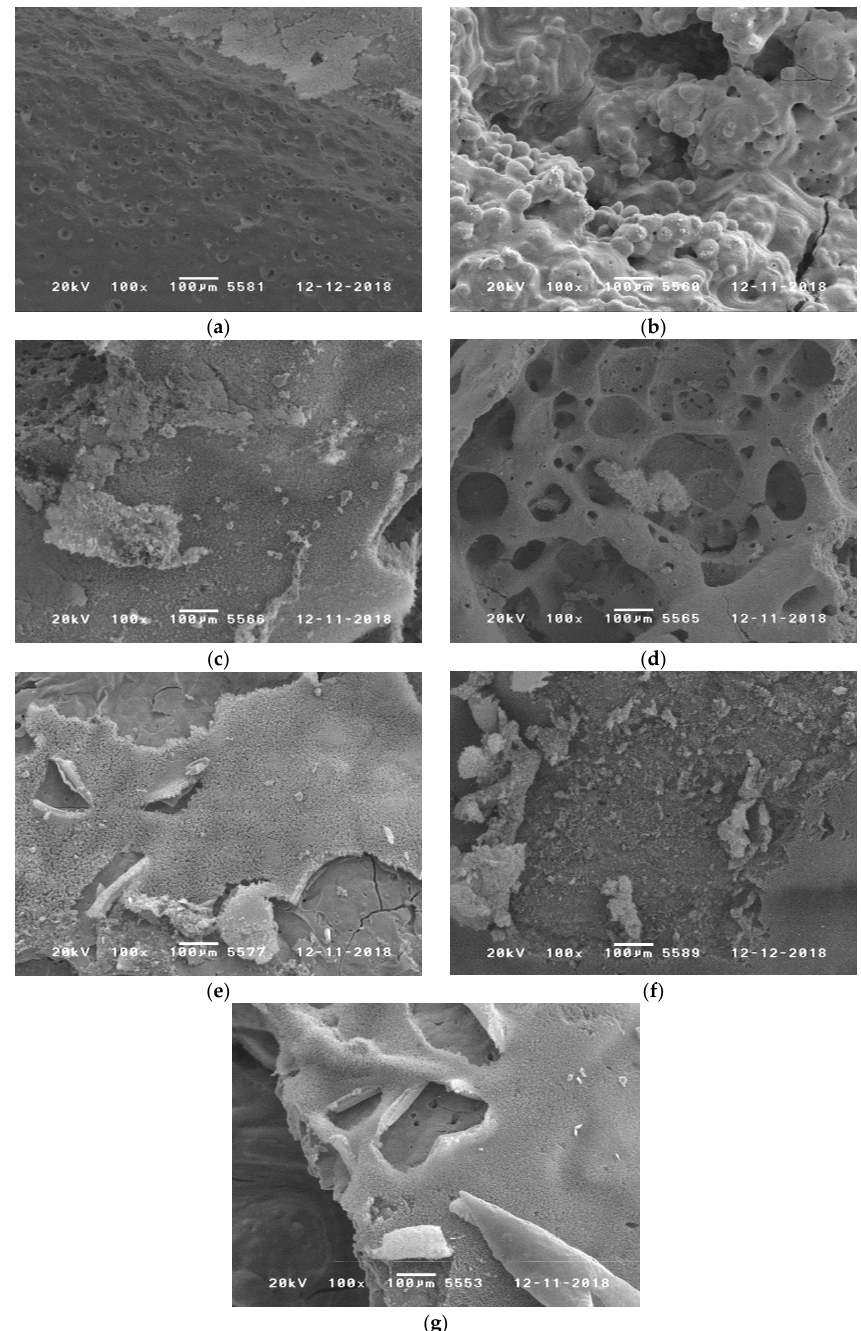
Figure 18. SEM images of the residues obtained after cone calorimetry for RTM6 samples at 35 kW · m − 2 for 500 s with: ( a ) 35% Actilox; ( b ) 30% Actilox + 5 % TAHHT-DOPO; ( c ) 30% Actilox + 5% TAHHT-DDPO surface; ( d ) 30% Actilox + 5% TAHHT-DDPO inside a hole; ( e ) 35% Dispersal; ( f ) 30% Dispersal + 5% TAHHT-DOPO; ( g ) 30% Dispersal + 5%